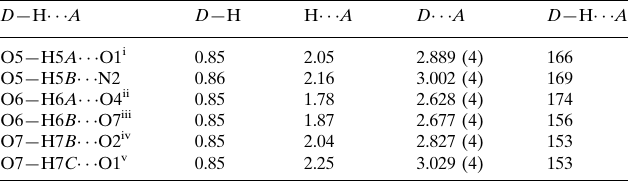
Hydrogen-bond geometry (A˚ , (cid:2)